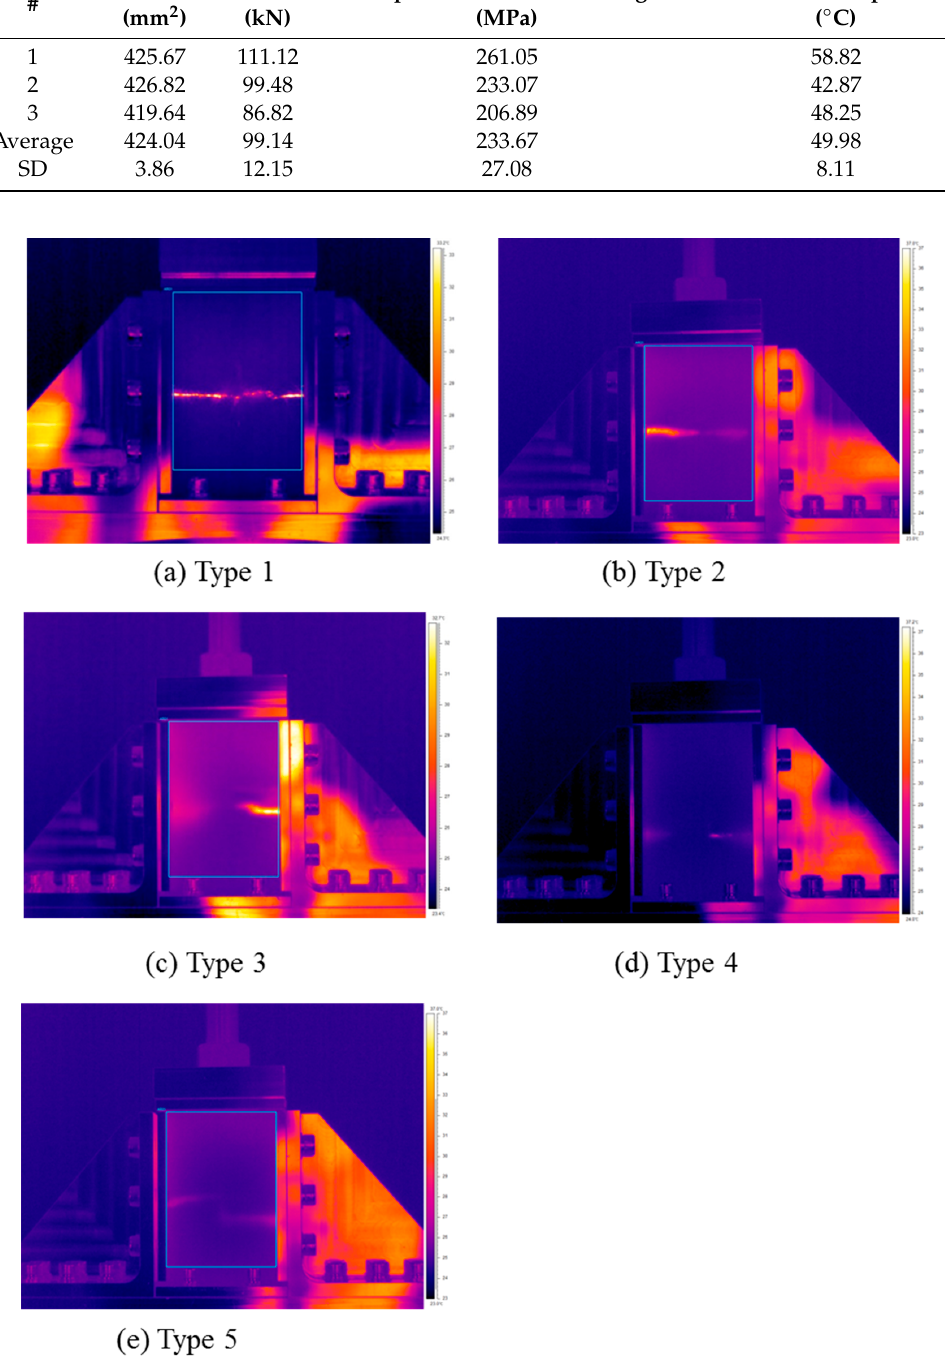
Figure 10. Thermal images of CAI tested specimens, ( a ) Type 1 (24 CFRP), ( b ) Type 2 (20CFRP:2EVA), ( c ) Type 3 (16CFRP:4EVA), ( d ) Type 4 (8CFRP:8EVA, inside), ( e ) Type 5 (8CFRP:8EVA,